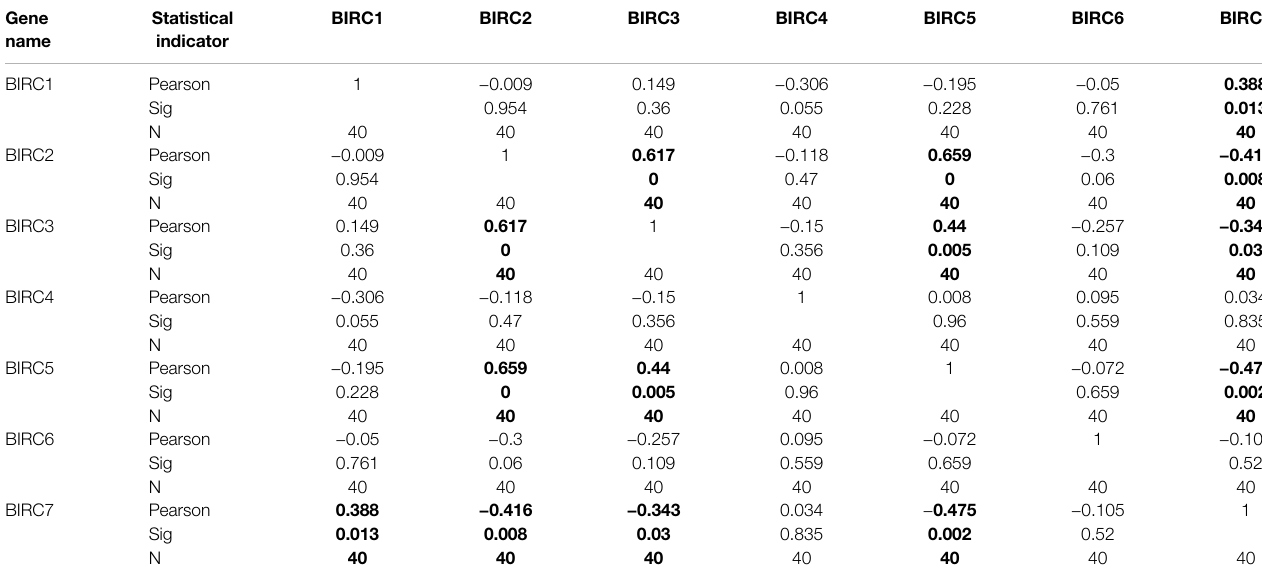
TABLE 3 | IAPs correlations in lung adenocarcinoma.